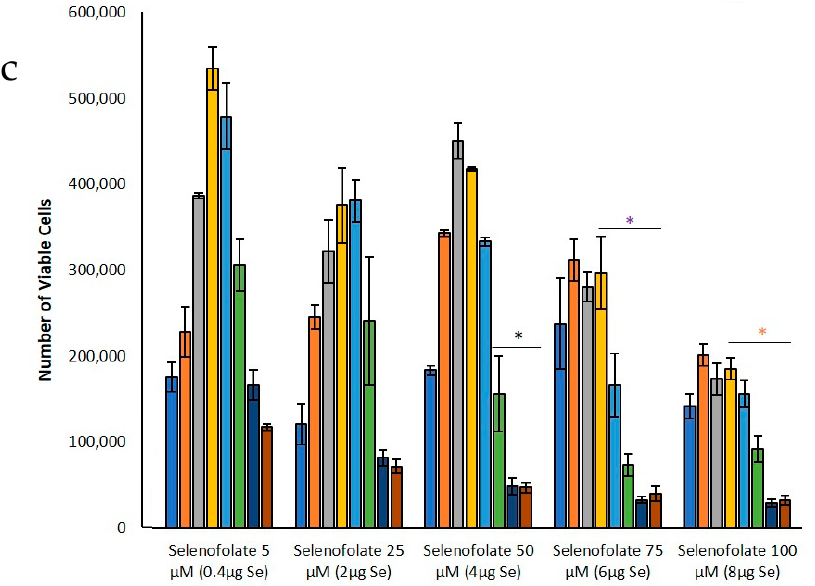
Figure 5. Analysis of treatment cytotoxicity in MDA-MB-468 cells. Cytotoxic e ff ects of ( a ) control and selenite, ( b ) Folic Acid, ( c ) Selenofolate treatments against MDA-MB-468 cells was determined as a function of percent cell viability. Forty-thousand cells were seeded and treated as shown (Day 0 = start of treatment) with 5 µ M, 25 µ M, 50 µ M, 75 µ M and 100 µ M folate and Selenofolate with Se equivalents of 0.4 µ g, 2 µ g, 4 µ g, 6 µ g, and 8 µ g respectively. Viable cells were counted and analyzed by Trypan Blue exclusion every 24 h for 7 days. The data are expressed as mean ± SE ( n = 3). Treatment results were compared using two sample t-tests and considered statistically significant if p ≤ 0.05 (indicated by *). Treatments that were statistically significant, p ≤ 0.05 are summarized in Table